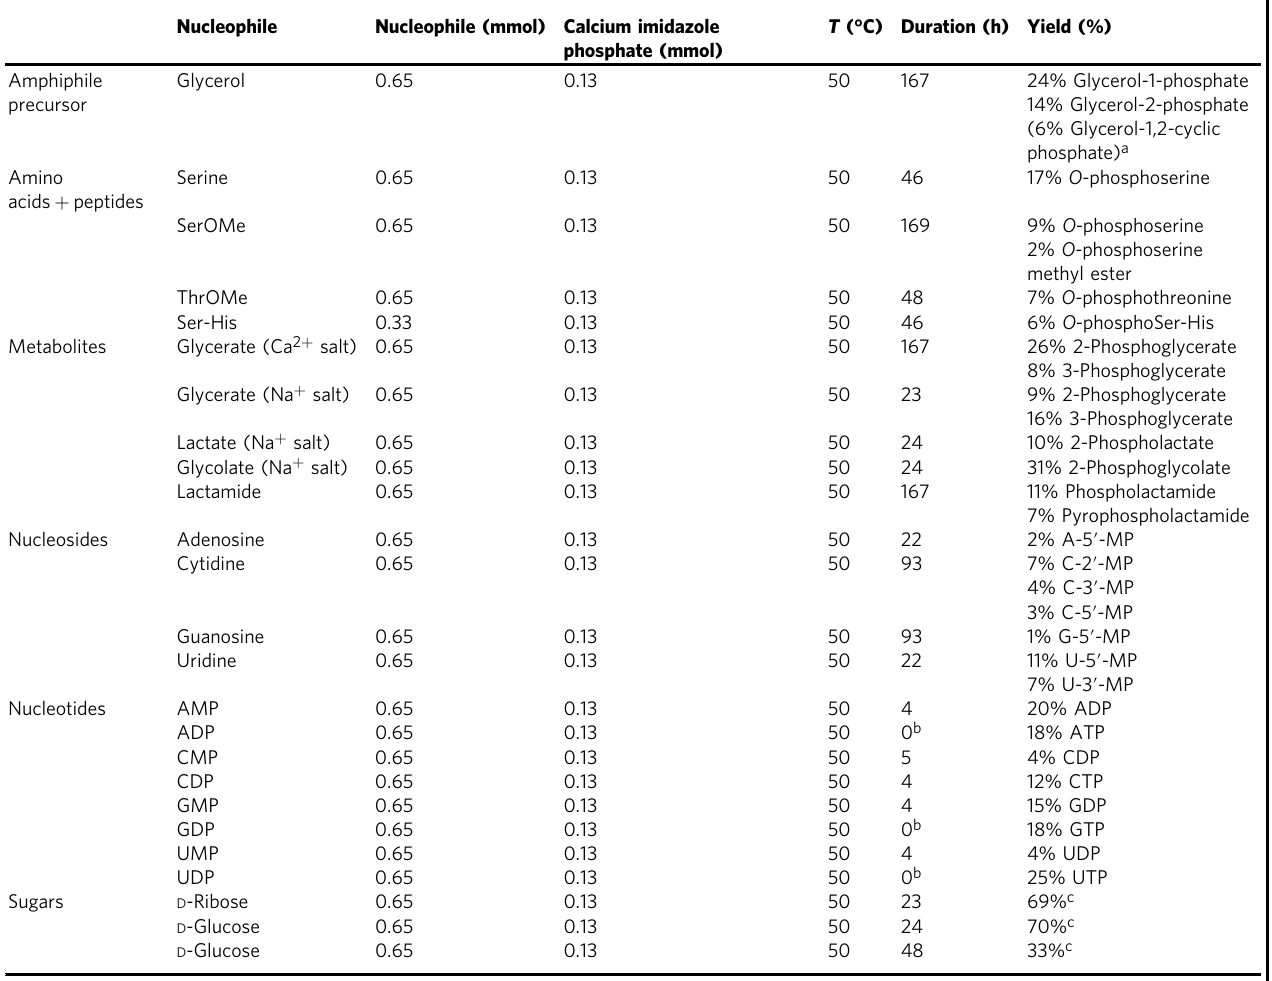
Table 1 The amphiphile precursors, amino acids + peptides, metabolites, nucleosides, nucleotides and sugars phosphorylated by imidazole phosphate under paste conditions (see SI Section